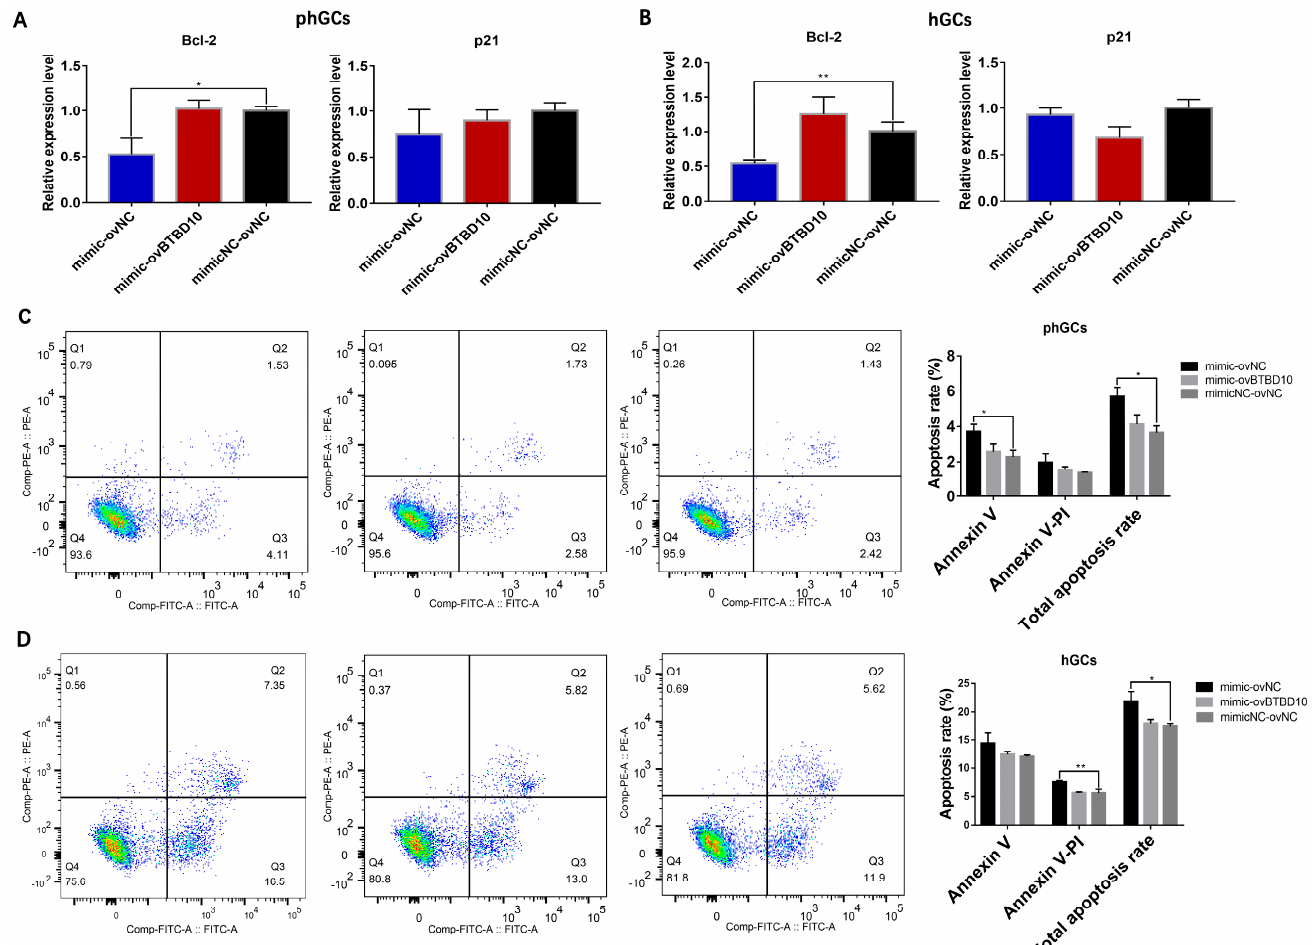
Figure 8. E ff ect of co–transfection of mimic and ovBTBD10 on phGCs and hGCs apoptosis. The ef- fect of the co–transfection of miR-202-5p mimic and ovBTBD10 on the expression of BCL2 and P21 in phGCs ( A ) and hGCs ( B ) (n = 3); the e ff ect of co–transfection of miR-202-5p mimic and ovBTBD10 on apoptosis rate of phGCs ( C ) and hGCs ( D ) detected by fl ow cytometer (n = 3). Data are means ± SD of technical replicates. * p < 0.05, ** p < 0.01.